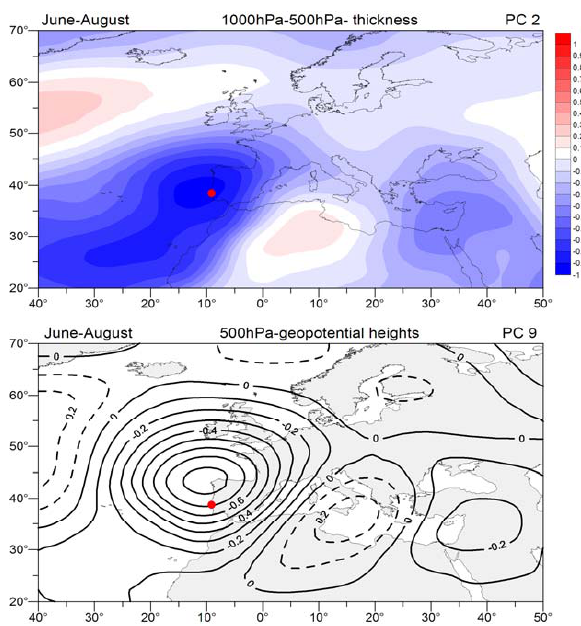
Figure 6: Loadings of PCs which are selected as dominant independent variables in the Fig. 6. Loadings of PCs which are selected as dominant indepen- multiple regression models for extreme maximum temperatures at Lisbon in summer dent variables in the multiple regression models for extreme max- (Location of the station marked by red dot). Upper figure: PC2 from the PCA of 1000hPa- imum temperatures at Lisbon in summer (Location of the station 500hPa-thickness in June to August 1950-2003. Lower figure: PC9 from the PCA of 500hPa- geopotential heights in June to August 1950-2003. marked by red dot). Upper figure: PC2 from the PCA of 1000hPa– 500hPa-thickness in June to August 1950–2003. Lower figure: PC9 from the PCA of 500hPa-geopotential heights in June to August